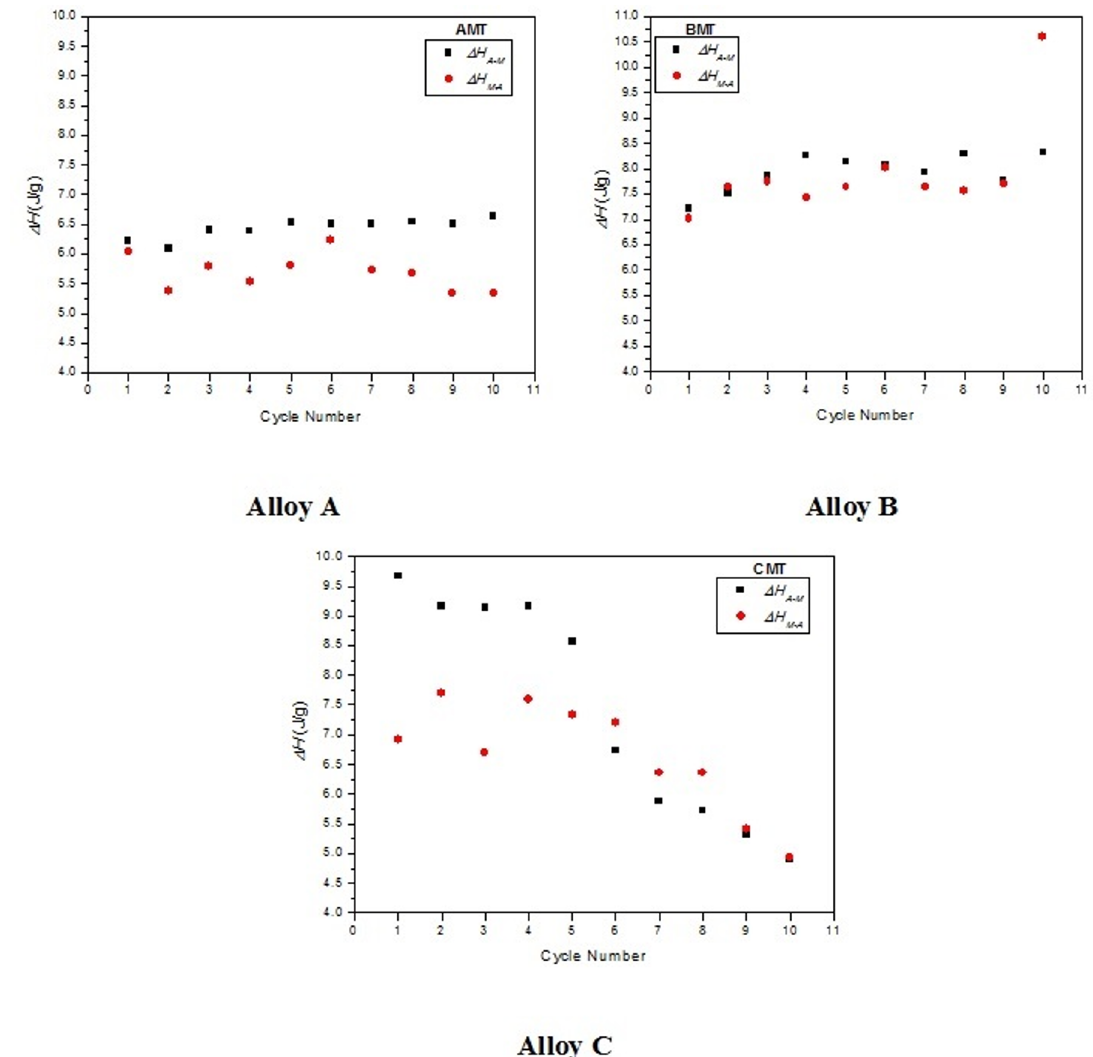
Figure 4. Evolution of the transformation enthalpies during thermal cycling of the of the Cu-Al-Ni alloys (modified and